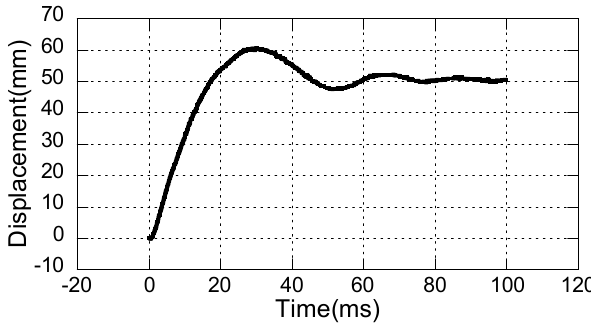
Figure 9. Time response of the displacement at midspan for test No. 14 (type A2, m = 300kg, Fig. 9. Time response of the displacement at midspan for test No. 14 (type A2, m=300kg, V col =5m/s). = 5m/s) V col